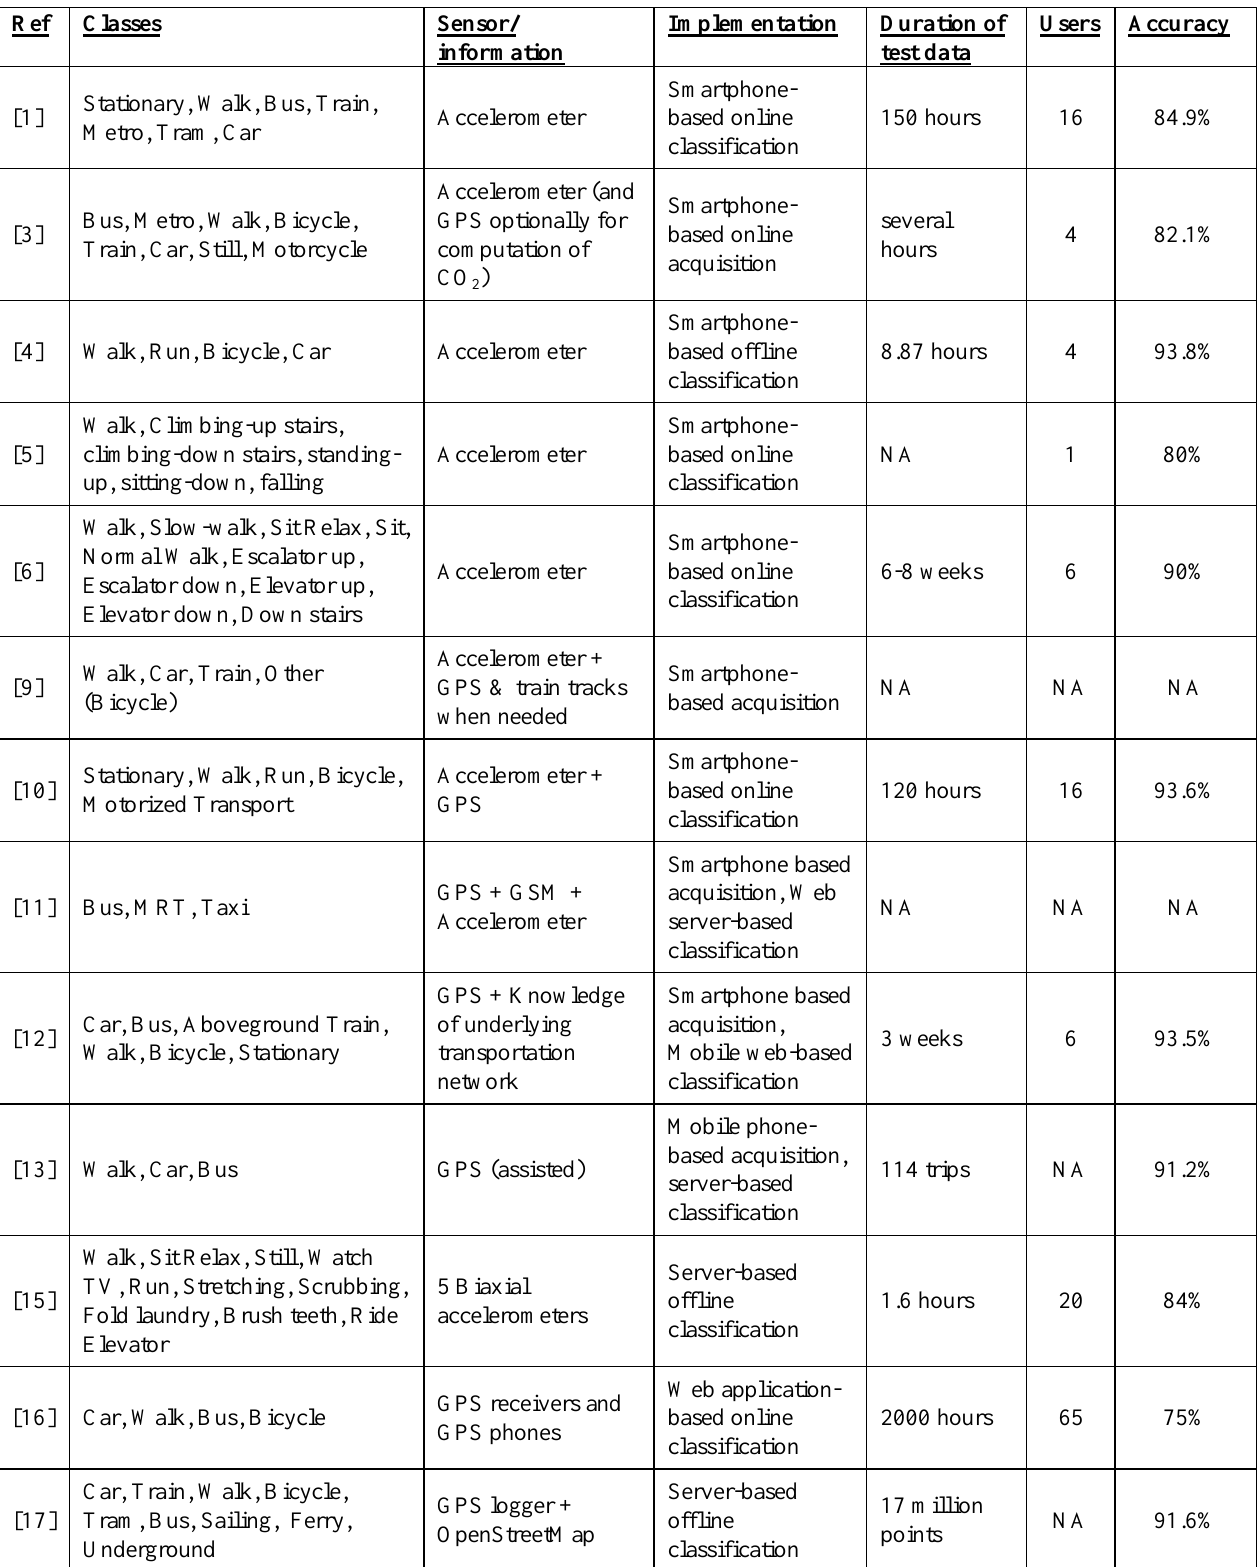
Table 5. Comparison of Transportation Mode Detection Solutions based on smartphones and other